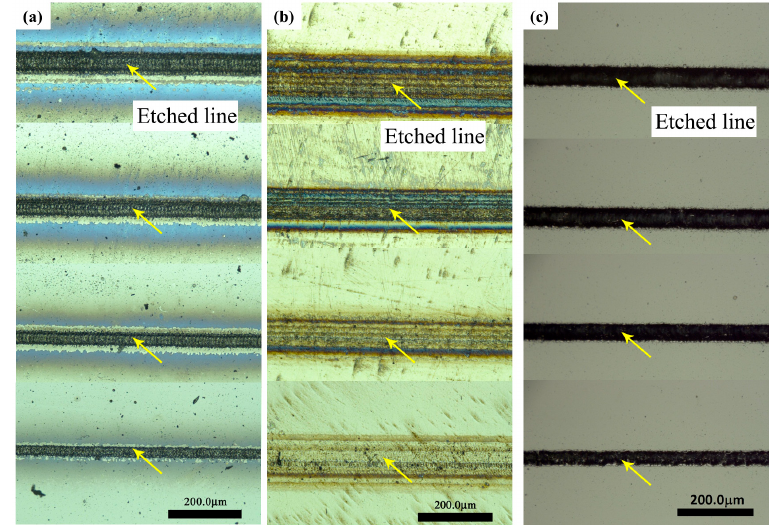
Figure 5. Optical images of straight lines etched by nanosecond laser: ( a ) Si, ( b ) stainless steel, and ( c ) Al film. The etching energy is about 80 μ J , 51 μ J , 39 μ J , and 17 μ J from top to bottom. The arrows indicate the etched lines.